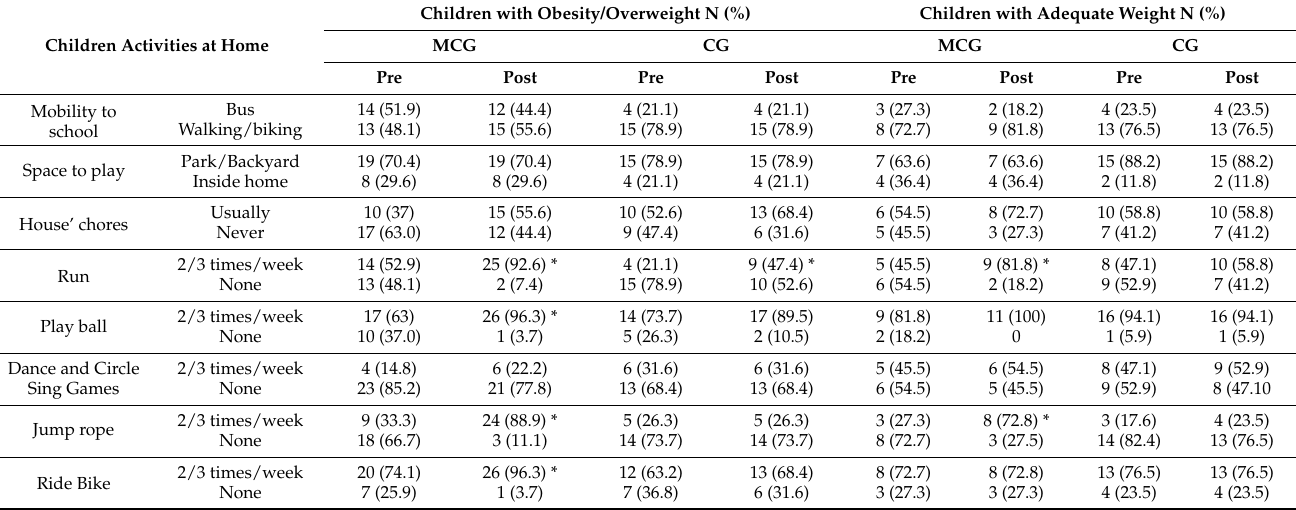
Table 1. Children with obesity/overweight and adequate weight activities at home: MCG and CG. Children with Obesity/Overweight N